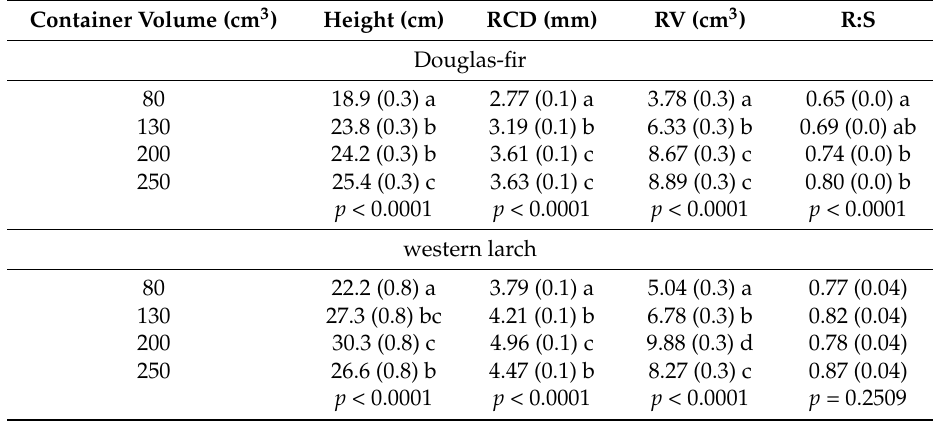
Table 2. Mean ( ± SE) height, root-collar diameter (RCD), root volume (RV), root dry mass:shoot dry mass (R:S) of Douglas fir and western larch seedlings at the end of one-year nursery culture across container types. Different letters within a species column indicate significant differences at α =